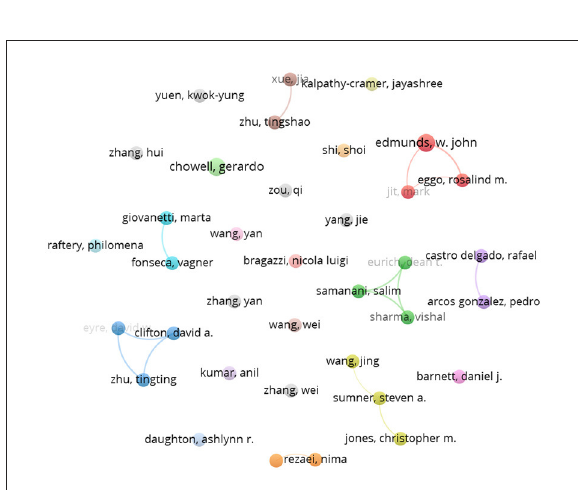
FIGURE5 Mapping knowledge domains of